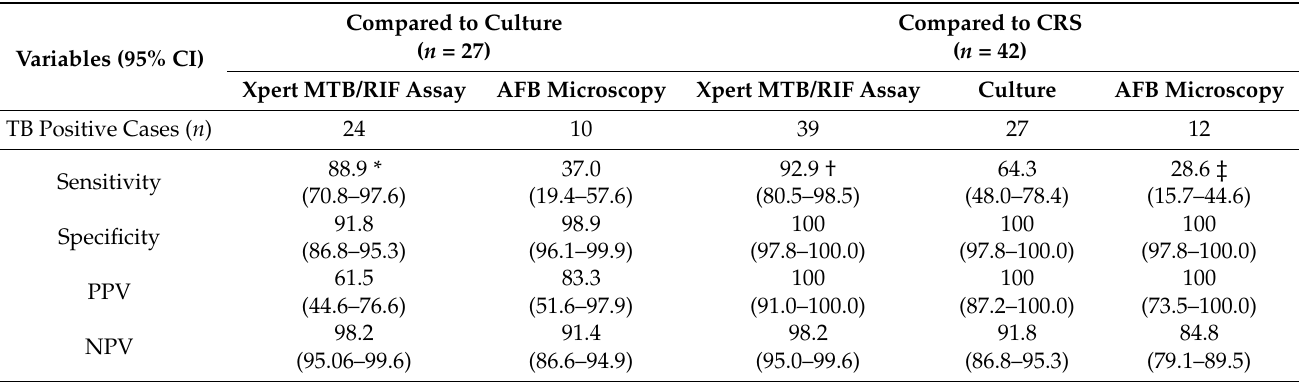
Table 3. Comparison of sensitivity, specificity and predictive values of different test methods accord- ing to culture and